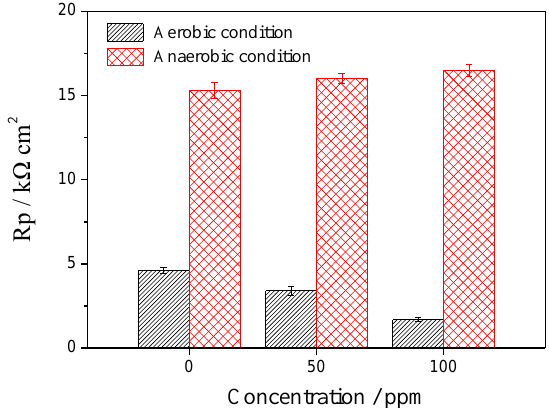
Figure 3. The variation of linear polarization resistance with glutaraldehyde concentration under aerobic and anaerobic conditions.